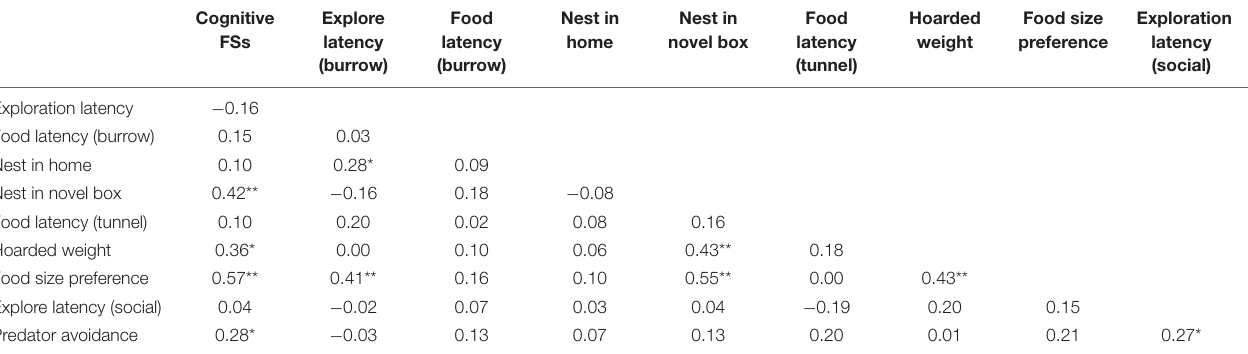
TABLE 5 | A correlation matrix of cognitive factor scores (indicative of general cognitive ability) and all measures of survival-related behaviors. Cognitive